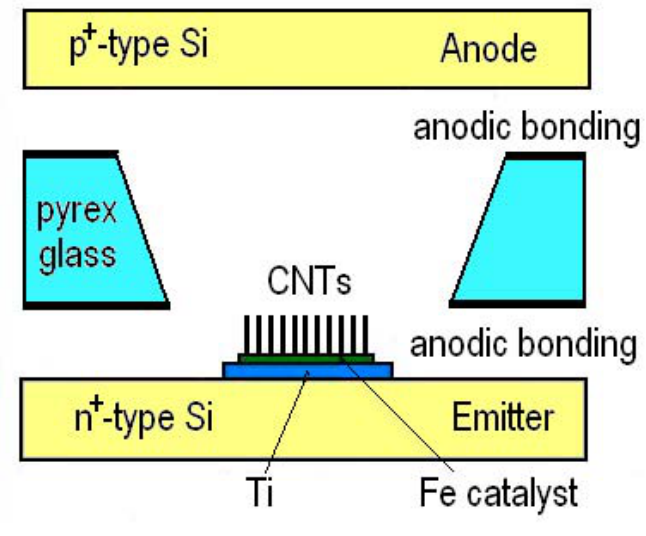
Figure 2. Schematic view of the sensor structure and an anodic bonding procedure.